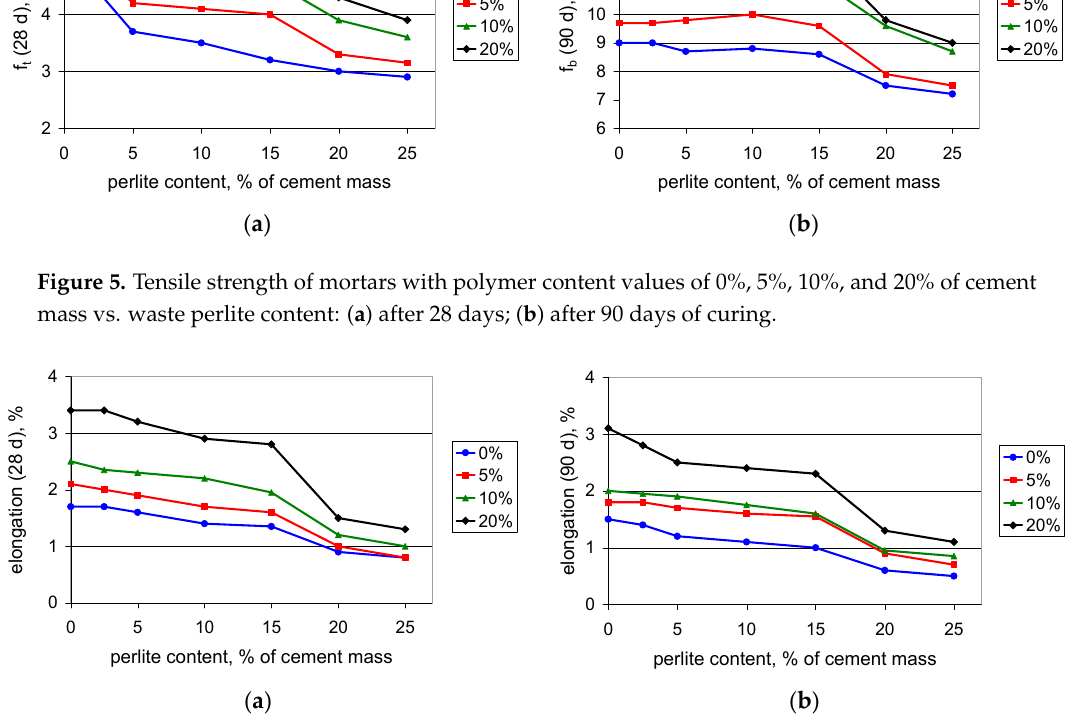
Figure 6. Maximum elongation at tension of mortars with polymer content values of 0%, 5%, 10%, and 20% of cement mass vs. waste perlite content: ( a ) after 28 days; ( b ) after 90 days of curing.